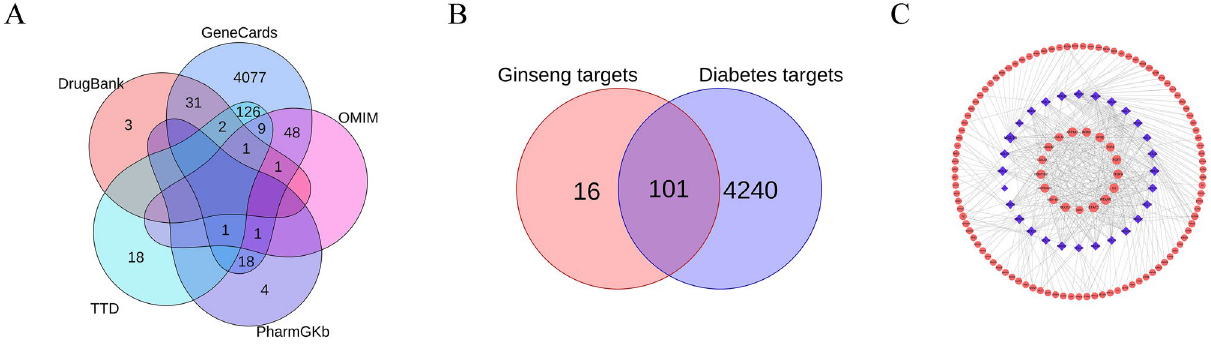
Figure 1. Ginsenoside-crosslinked targets visualization and core target screening. All disease targets DM ( A ). Ginsenosides-Disease intersection targets ( B ). Ginsenosides-intersection targets Network ( C